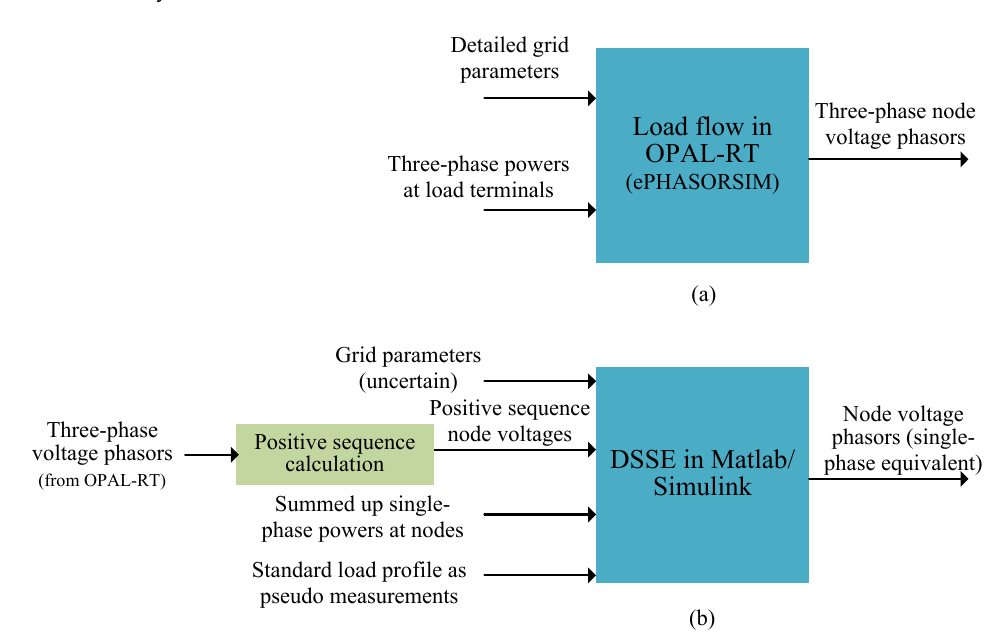
Figure 7. ( a ) Offline simulation using smart meter data in OPAL-RT and ( b ) simulation of DSSE in